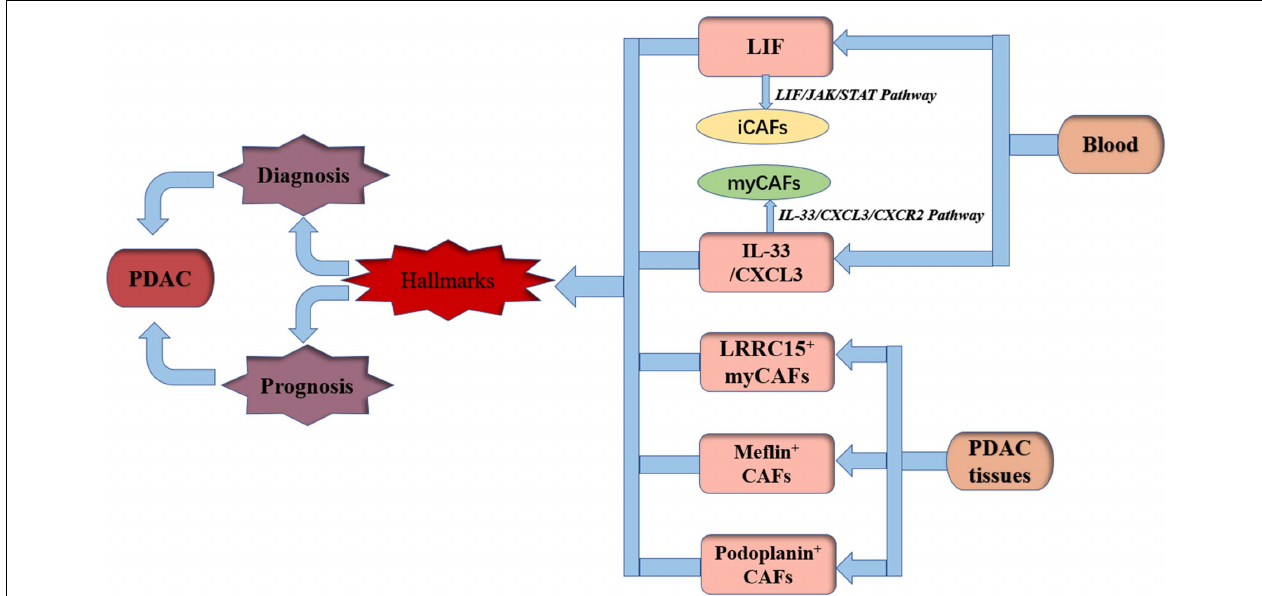
FIGURE 2 | Hallmarks for diagnosis and prognosis of PDAC by CAFs. PDAC, pancreatic ductal adenocarcinoma; LIF, leukemia inhibitory factor; iCAFs, inflammatory cancer-associated fibroblasts; myCAFs, myofibroblastic cancer-associated fibroblasts; IL-33, interleukin-33; CXCL3, chemokine (C-X-C motif) 3; LRRC15, 15-leucine repeat membrane protein; JAK, Janus kinase; STAT, signal transducer and activator of transcription; CXCR2, C-X-C motif chemokine receptor